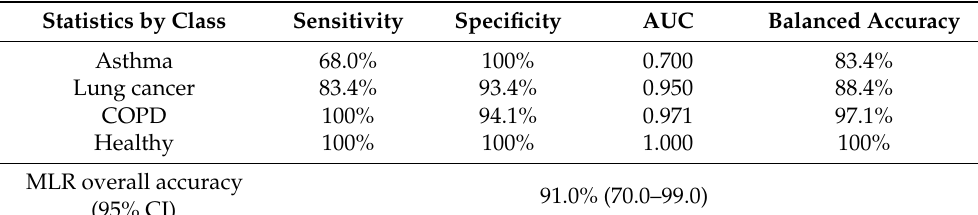
Table 4. MLR model performance (AUC = area under the curve, CI = confidence